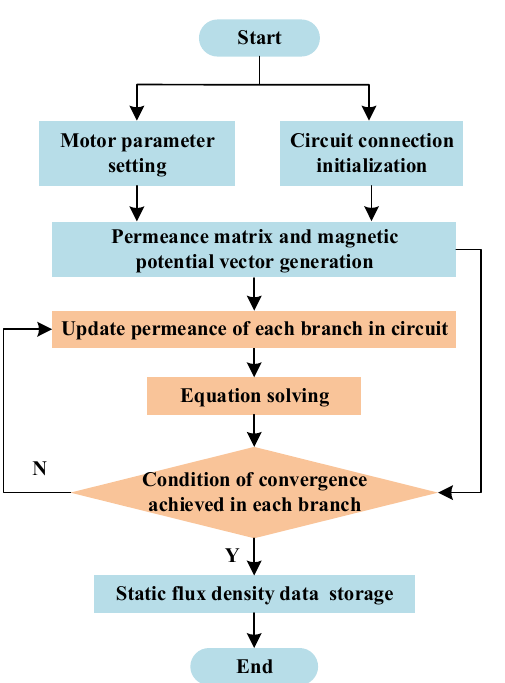
Figure 3. Calculation flow chart of the MEC model at each rotor position.